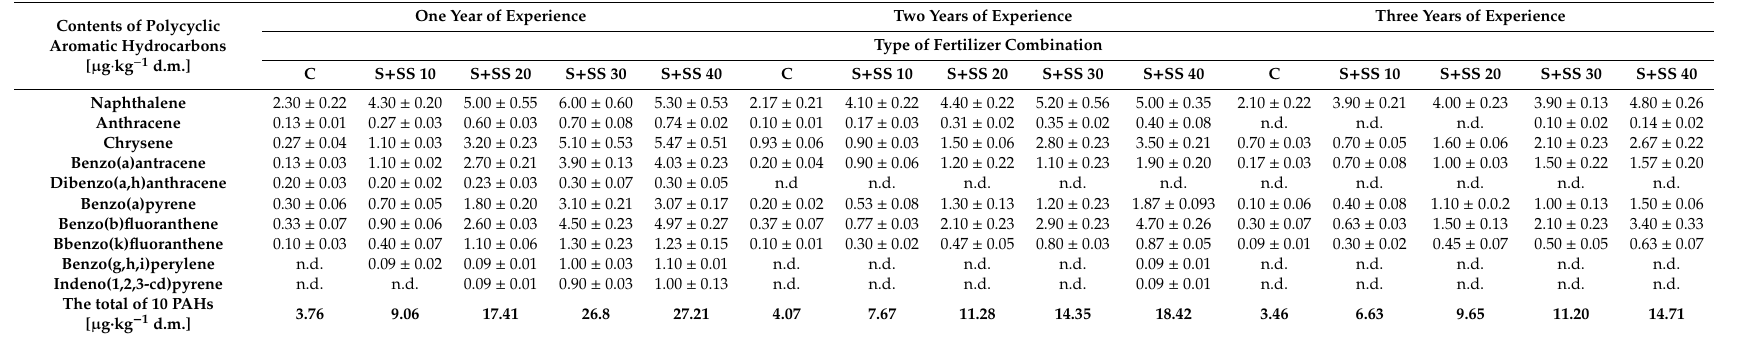
Table 3. Content of PAH in soil mixtures [ µ g / kg d.m.].